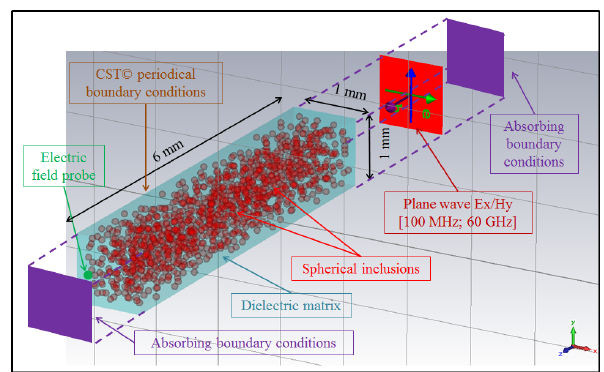
Figure 1: Mockup of numerical setup based upon 3-D CST (cid:114) model of the material (transient FIT solver) includ- ing boundary conditions and dimensions. The properties of the two-phases mixture are as follows: (cid:15) 1 = 5 (cid:15) 0 , σ 1 = 0 S/m, (cid:15) 2 = (cid:15) 0 , σ 2 = 1 , 000 S/m, and ν = 1 − η = 0 . 10